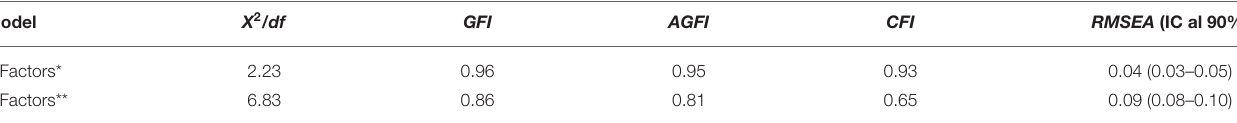
TABLE 2 | Goodness of fit indices for each model of the CFA of the WSQ-SP ( N = 651). Model X 2 /df GFI AGFI CFI RMSEA (IC al